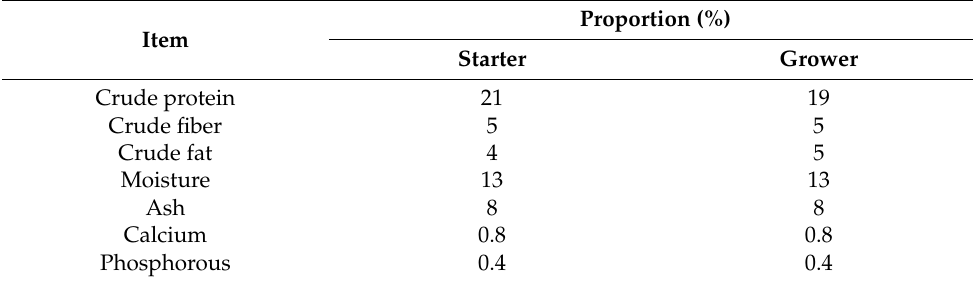
Table 1. Nutrient composition of feed.